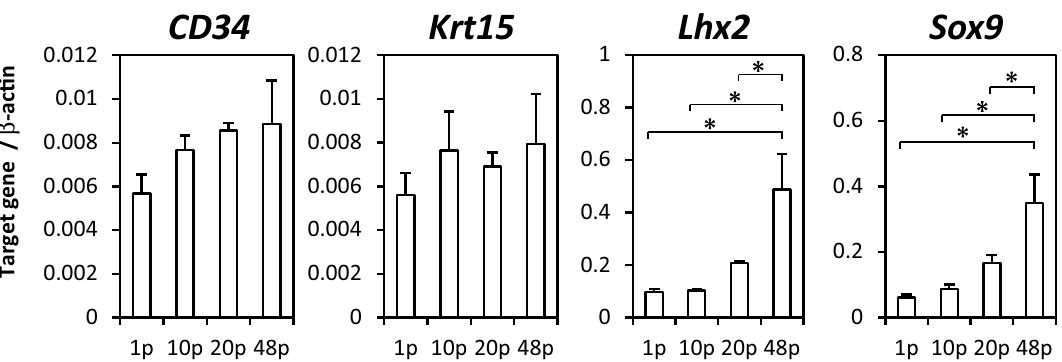
Figure 4. Gene expressions in HFSCs passaged with M-CnT for long term. Gene expressions of epithelial stem cell markers ( CD34, Krt15, Lhx2, Sox9 ) in cultures of 1p-, 10p-, 20p-, and 48p-HFSCs with M-CnT were examined using real-time qRT-PCR. * p <